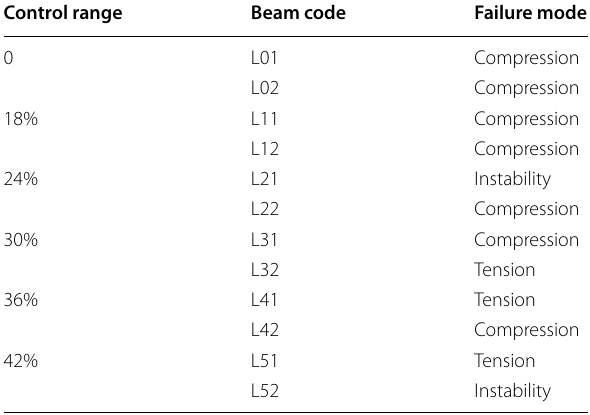
Table 3 Failure modes of specimens Control range